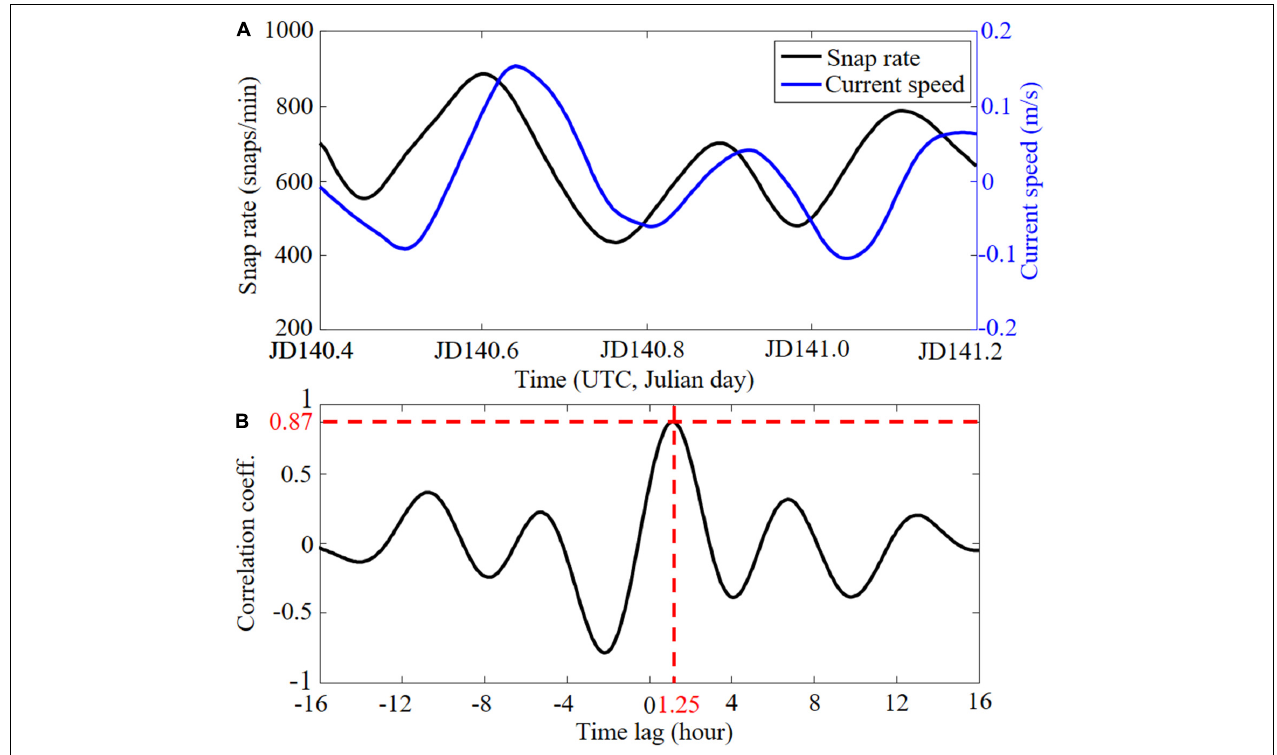
FIGURE 10 | (A) Comparison between the snap rate (black) and current speed (blue) from JD 140.4 to JD 141.2 (see Figure 9C ). (B) Cross-correlation between snap rate and current speed. The maximum correlation indicates that the snap rate peaks 1.25 h before the local maximum